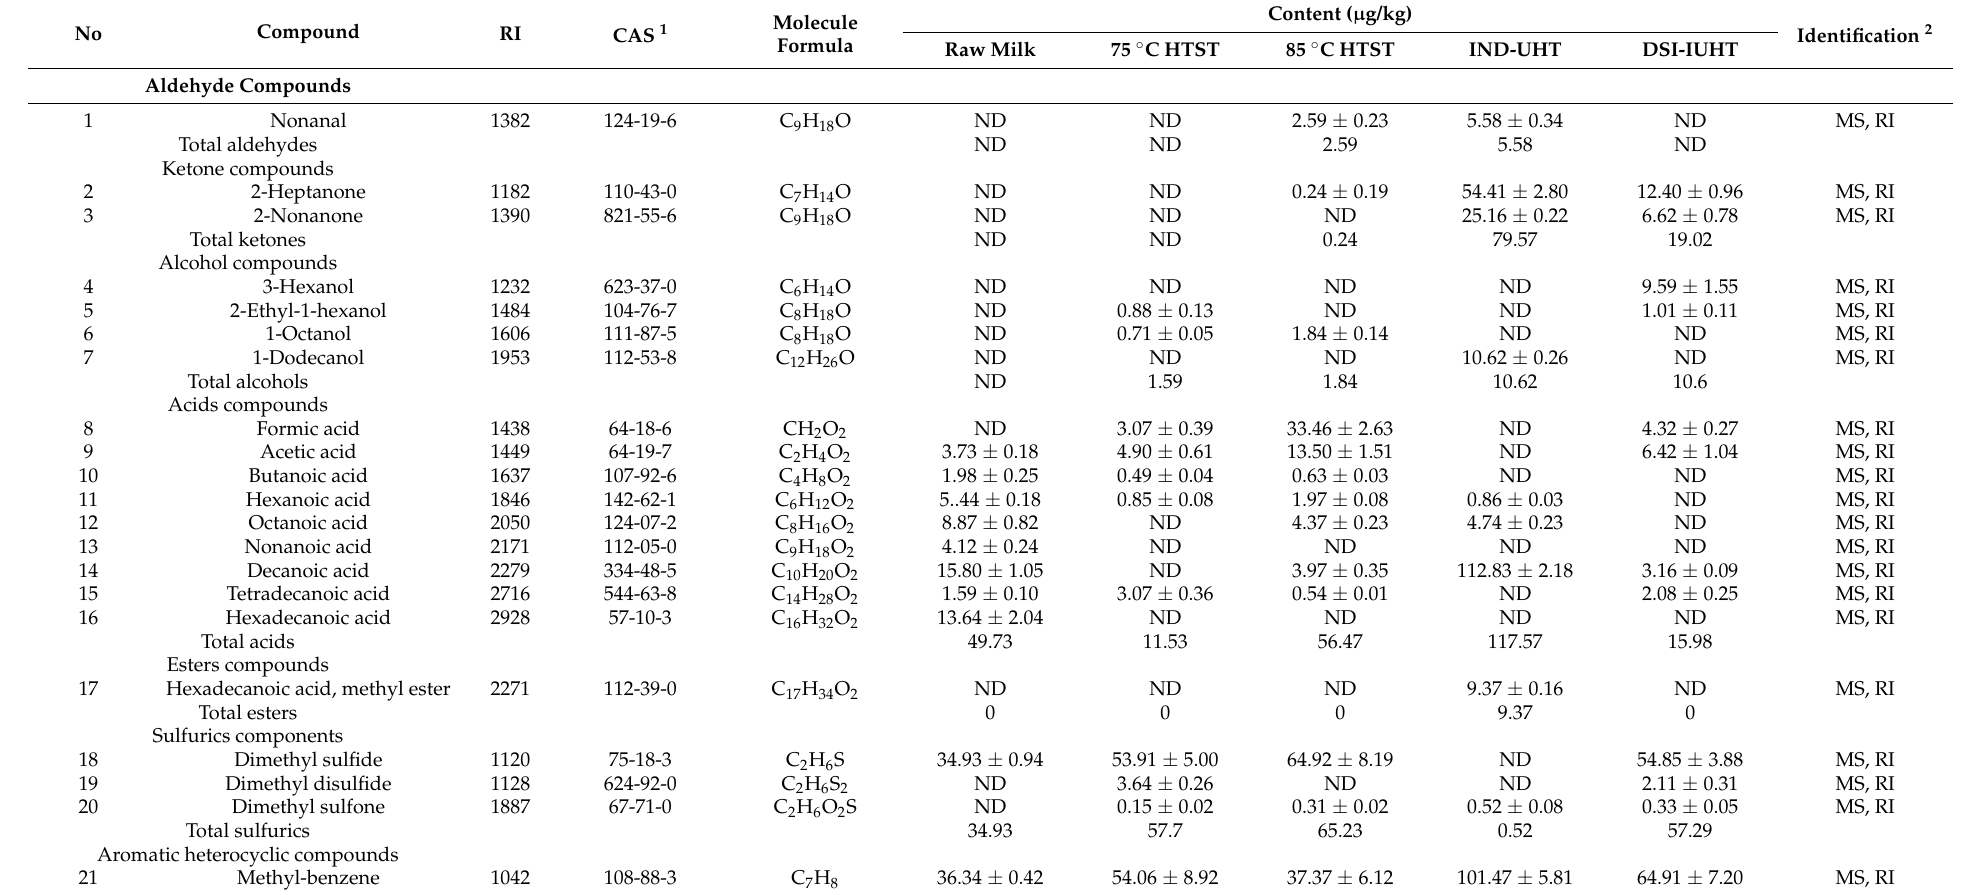
Table 2. Solid-phase microextraction (SPME) analysis of the volatile compound (VC) contents in the different milk